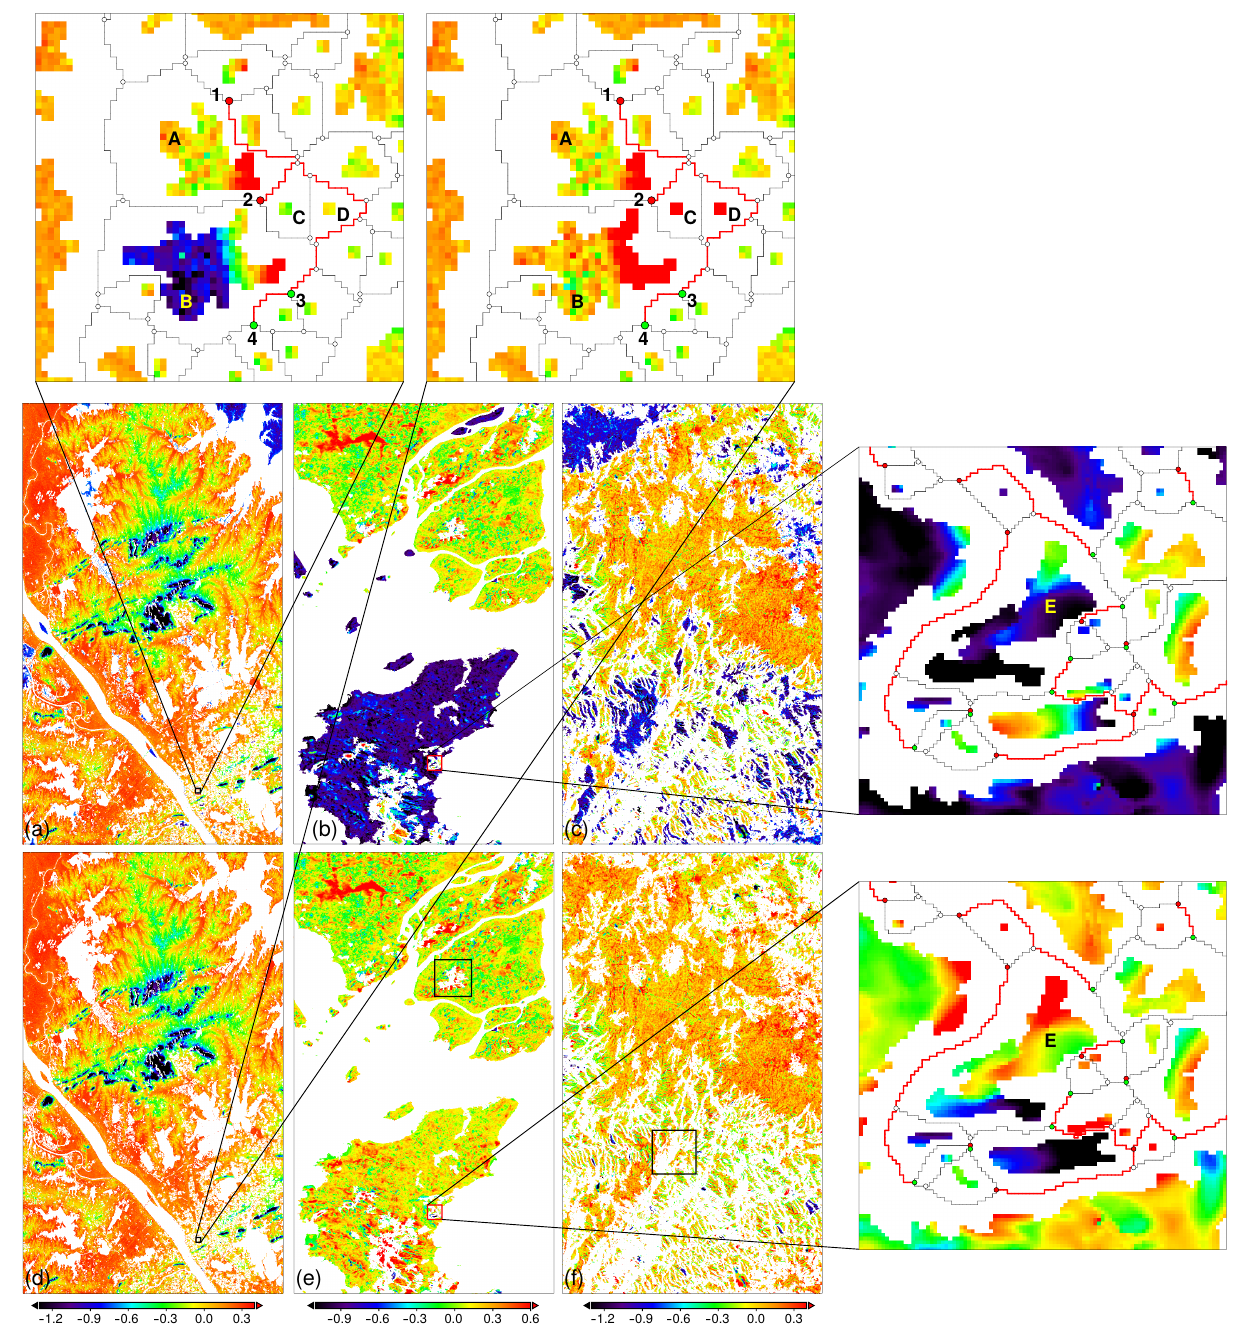
Figure 12. The local unwrapped phase in the continuous regions for Wuhan ( a ), Singapore ( b ), and Songshan ( c ) and their global aligned versions in ( d – f ), respectively. Details of windowed areas with boundaries (black), residues (red for positive, green for negative), and coupling edges